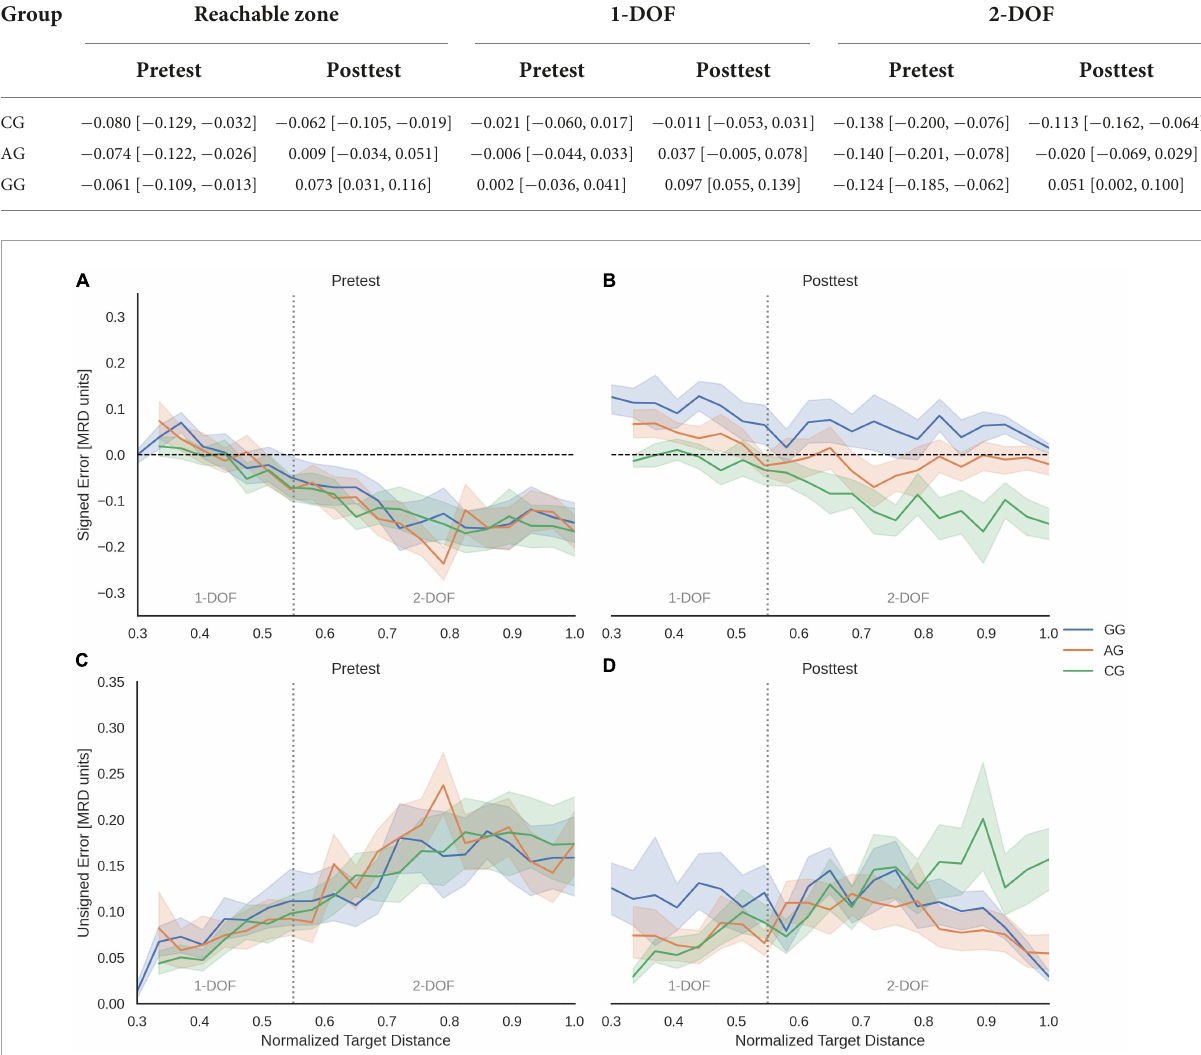
FIGURE4 Mean of SE and UE according to Normalized Target Distances for Pretest (A,C) and Posttest (B,D) phases and each group. Color shading represents the 95% confidence intervals. Dashed black horizontal lines correspond to ideal response (no error), while dotted gray vertical lines represent the limit between 1- and 2-DOF regions.